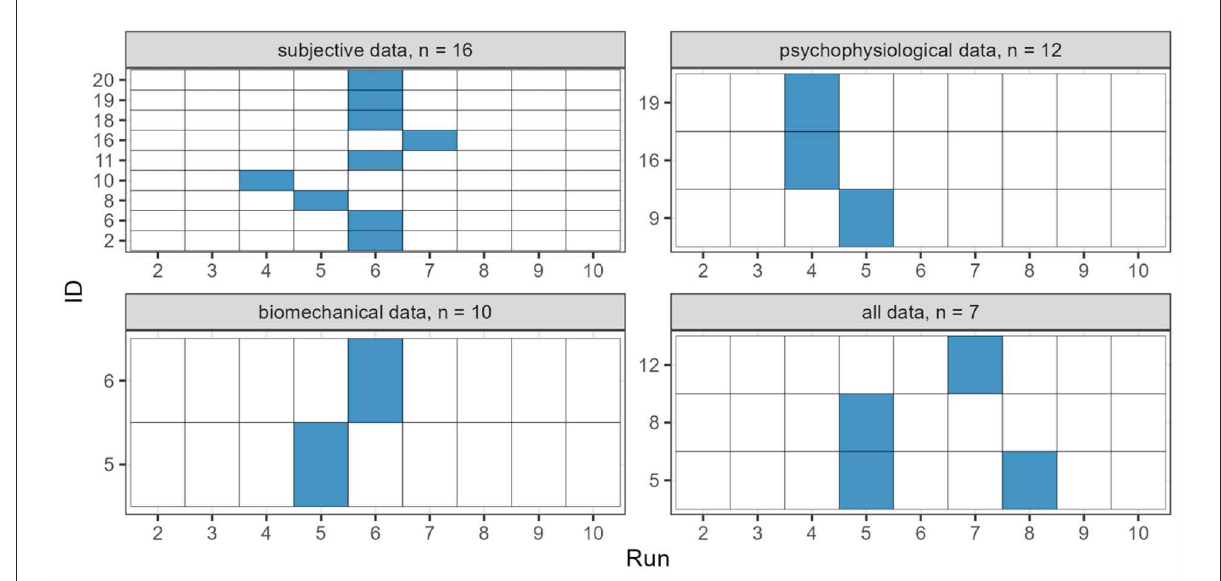
FIGURE5 Detected change points in the time series; note that the number of participants, as indicated in the header, vary by data level; Subjective data consist of: fatigue, vitality, worry, and calm; psychophysiological data consist of: breathing rate, mean, breathing rate, cv, breathing rate, slope, and breathing depth amplitude, mean; biomechanical data consist of: turn duration, SD, edge angle symmetry, mean, radial force, mean, and motion quality score,